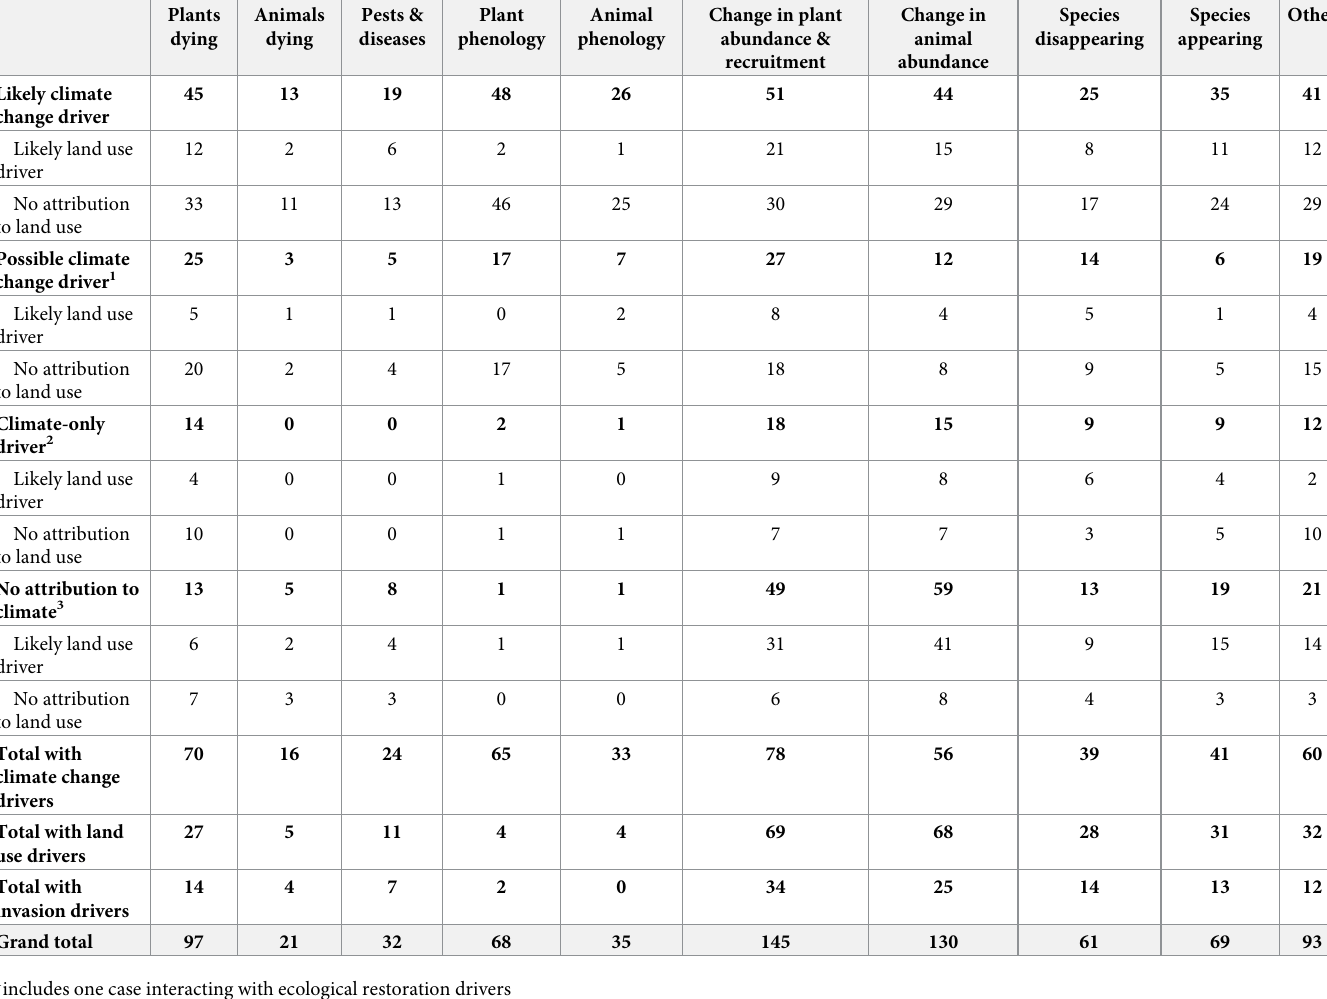
Table 6. Number of text anecdotes for each primary change type with respondent attributions to different drivers, highlighting interactions among climate and land use drivers. Plants